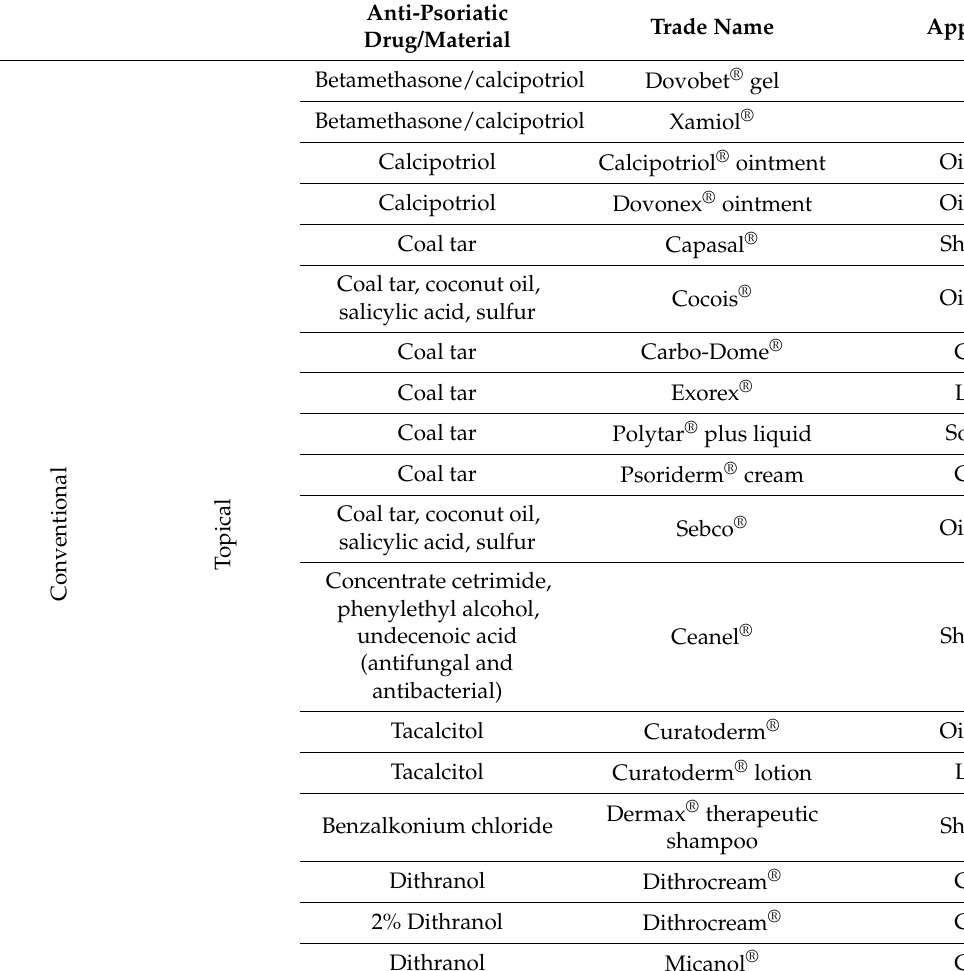
Table 1. List of current treatments available for psoriasis and its respective